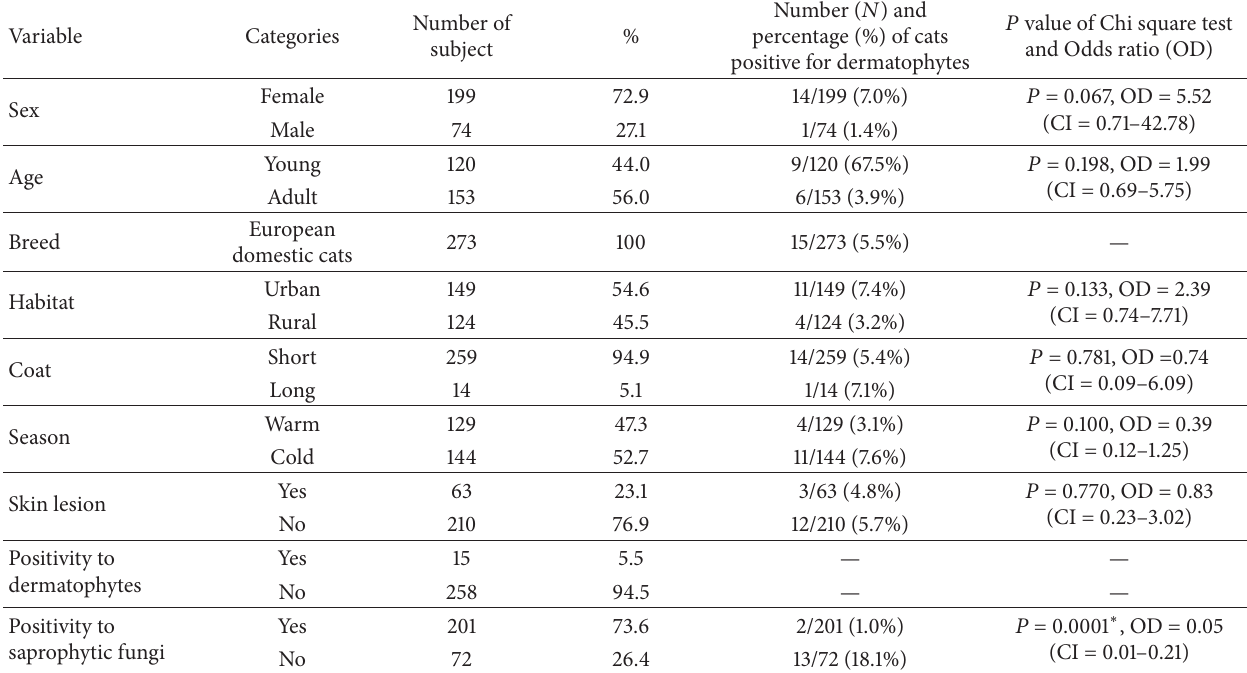
Table 1: Epidemiological data of the population, prevalence of dermatophytes in relation to the epidemiological data and 𝑃 value of Fisher’s exact test and Odds ratio (OD) for each risk factor considered in a 273 stray cats with and without clinical signs living in north Italy.